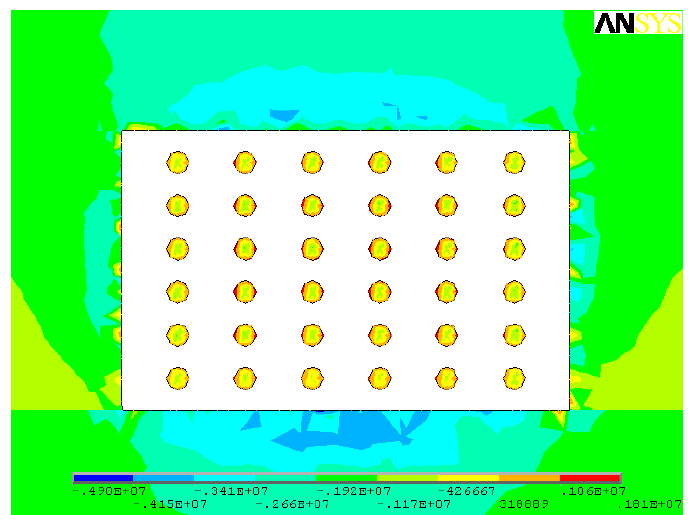
Figure 16. Maximum principal stress distribution in the middle of the pillar at 1480 mL of scheme 1 (parameters of scheme 1: stope height 2.5 m, pillar diameter 2 m, pillar spacing 4 m, pillar row spacing 6 m).